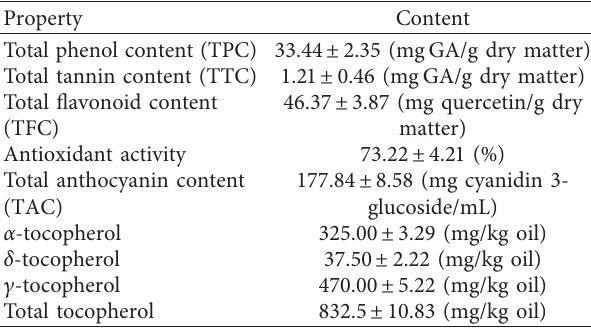
Table 5: TPA, TTA, TAC, TFC, AA%, and tocopherol contents of sour cherry kernel oil.